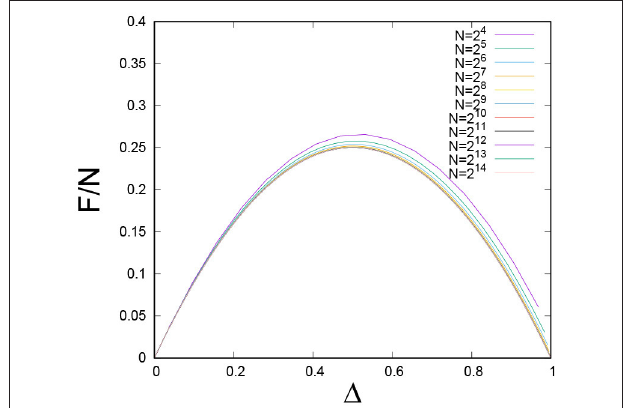
FIGURE 4 | The force-load curve as we iterate the order-space renormalization group. The initial number of fibers was N 2 15 and the uniform distribution on = the unit interval was assumed. Averages were taken over 10 6 samples.